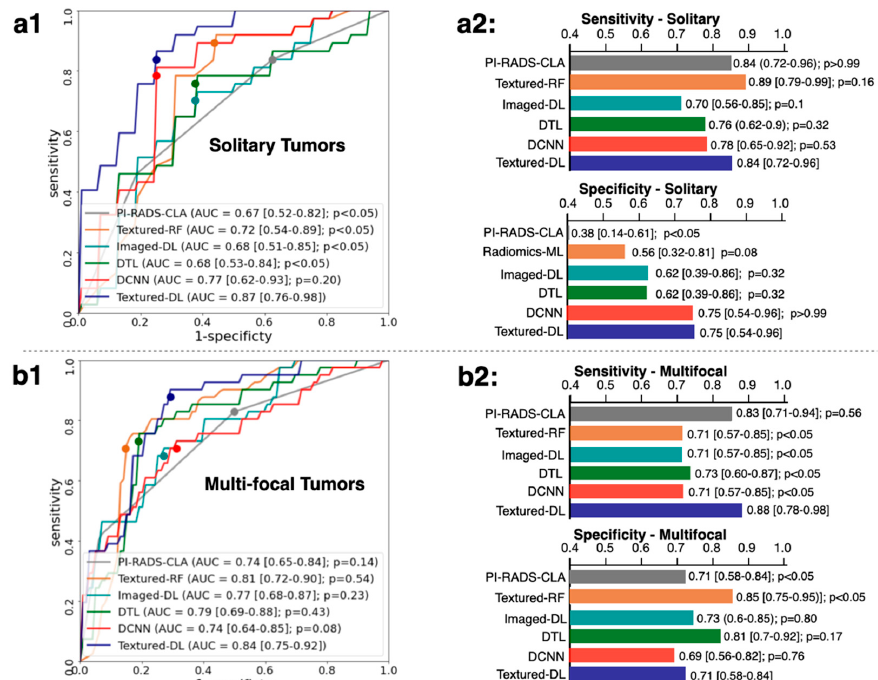
Figure 5. Comparisons of ROC, AUC, sensitivity, and specificity between the Textured-DL and baseline methods in the solitary ( a1 , a2 ) and multi-focal tumors ( b1 , b2 ). CIs were provided in the square brackets. p values for the comparison between the baseline methods and the Textured-DL were also provided.